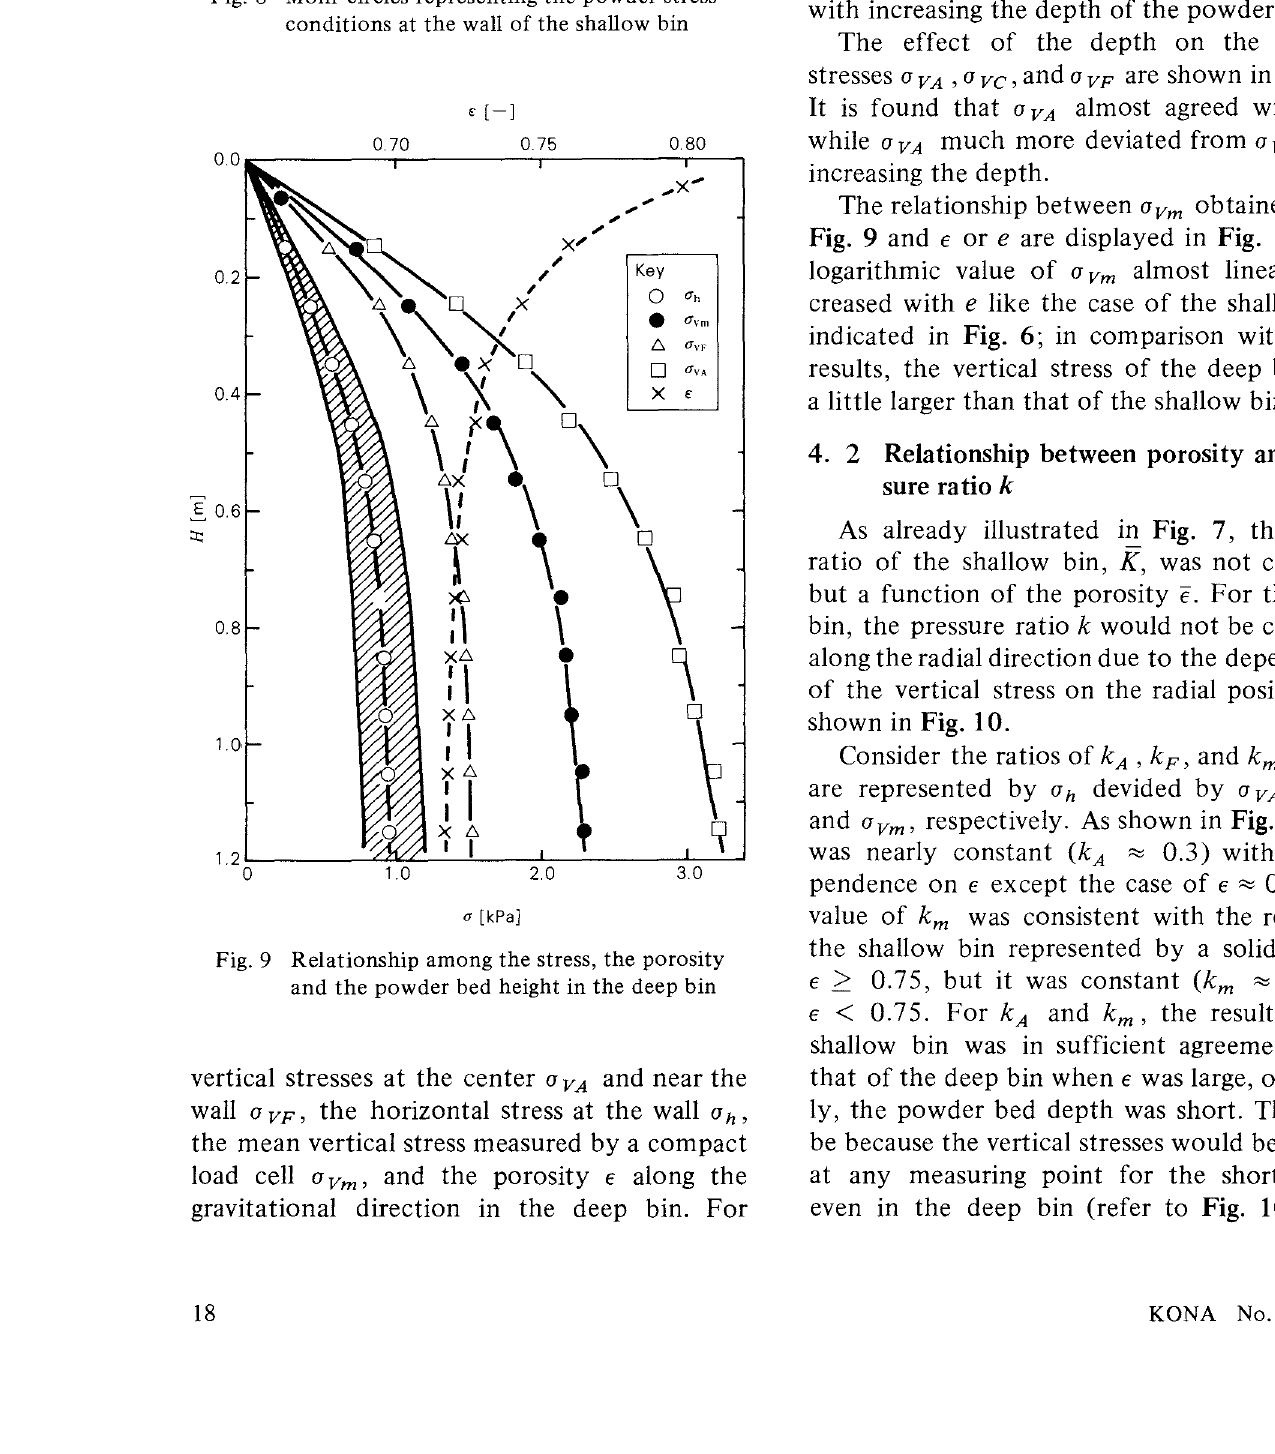
Fig. 8 Mohr circles representing the powder stress conditions at the wall of the shallow bin